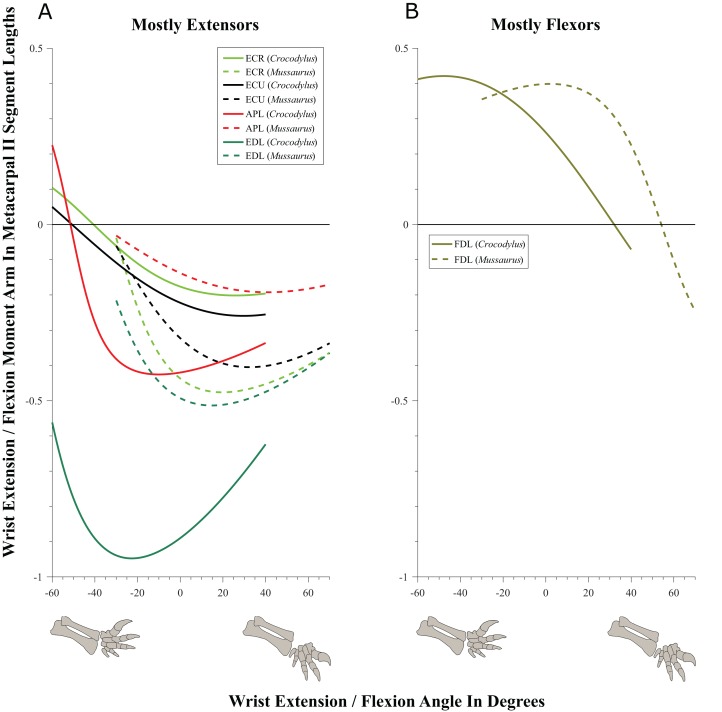
Extension/flexion moment arms around the wrist, normalized to metacarpal II length, plotted against extension/flexion joint angles for Crocodylus and Mussaurus.(A) Mostly extensors; (B) mostly flexors. Negative moment arms and wrist joint angles correspond to extension, while positive values correspond to flexion. For muscle abbreviations see Table 1.